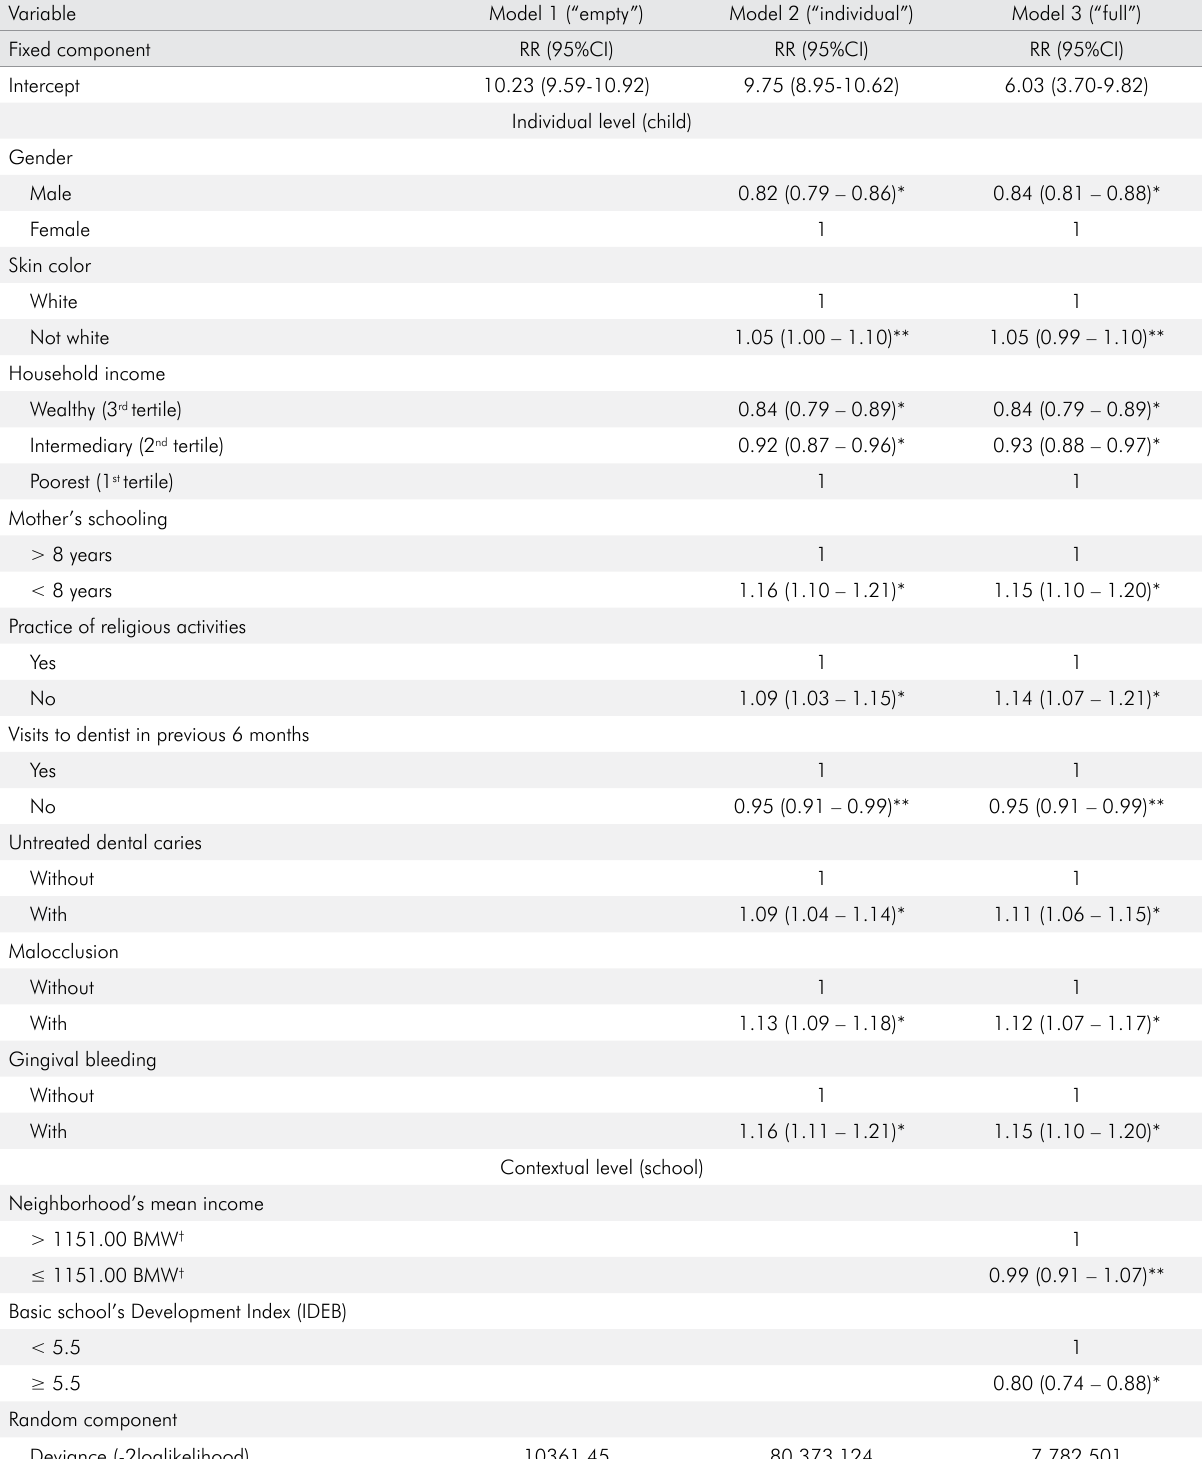
Table 4. Individual and contextual factors associated whit CPQ11-14 averages – Adjusted multilevel analysis poisson regression: 1,134 12-year-old children, Santa Maria – RS,